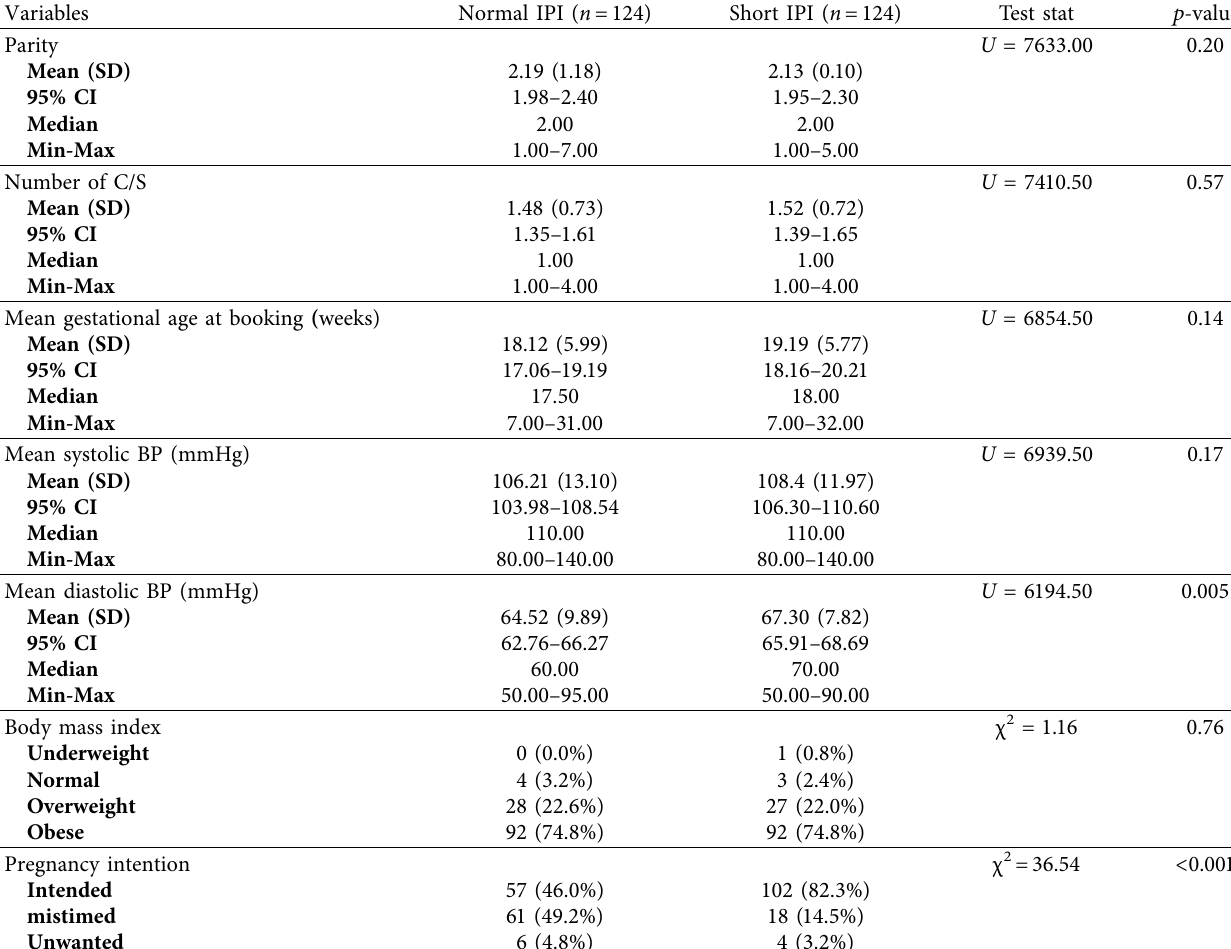
Table 2: Clinical characteristics of the study participants.